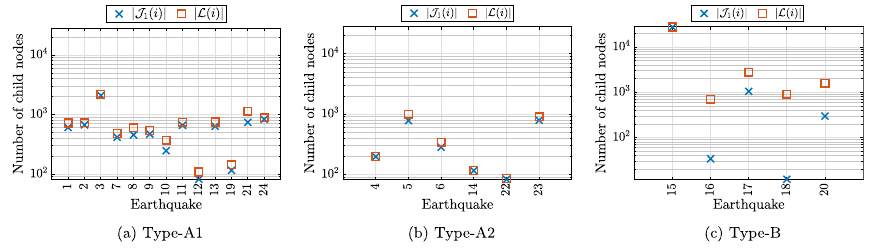
Fig. 8 Comparison of the numbers of child nodes of J 1 ( i ) and L ( i